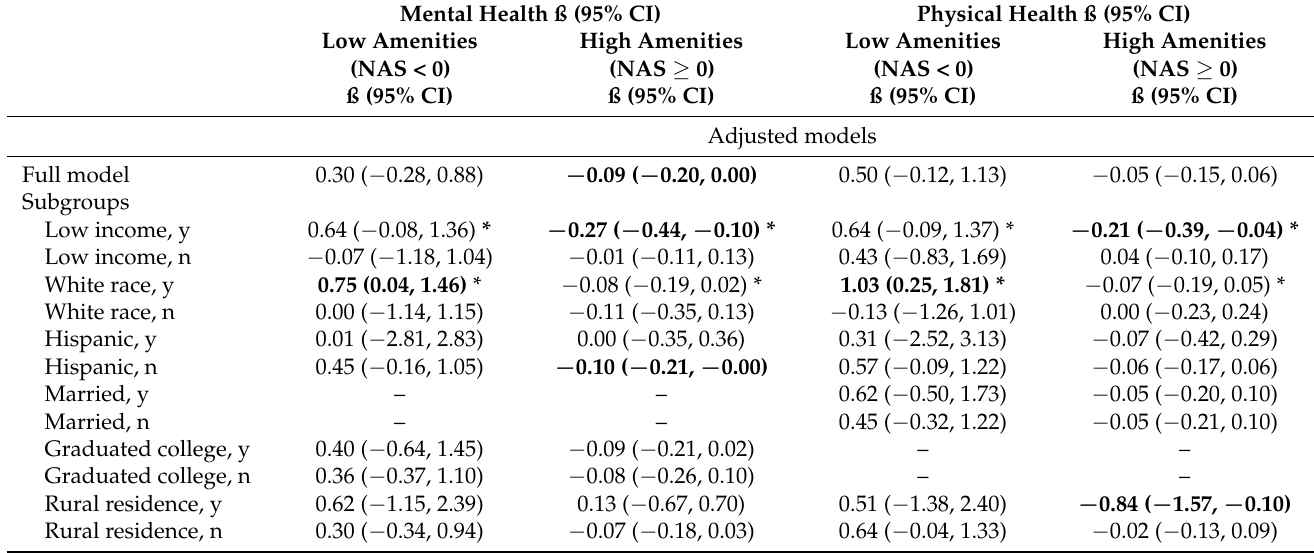
Table 3. Multivariable piecewise spline regression overall and subgroup